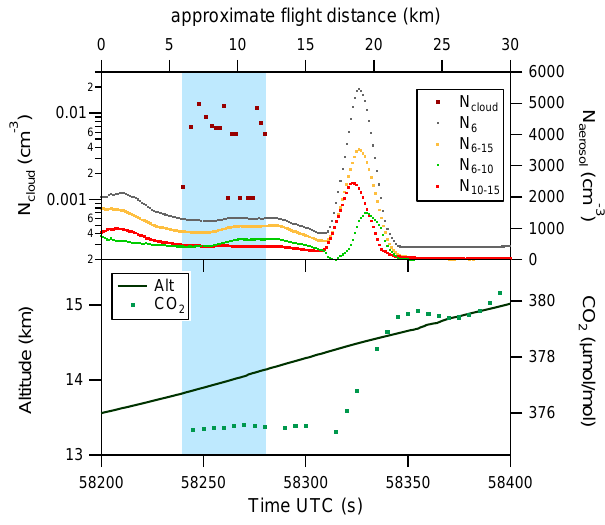
Fig. 9. Segment of the flight time series recorded on 11 August 2006. The blue shading indicates one of the aged outflow events encountered during this